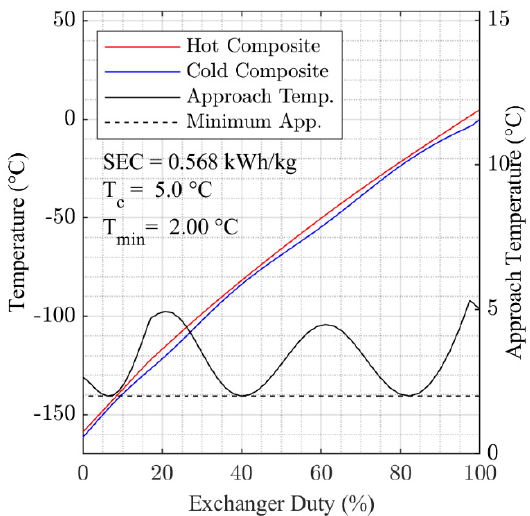
Figure 6. Composite curves in HX-1 and key performance parameters, 5 °C cooling temperature case.